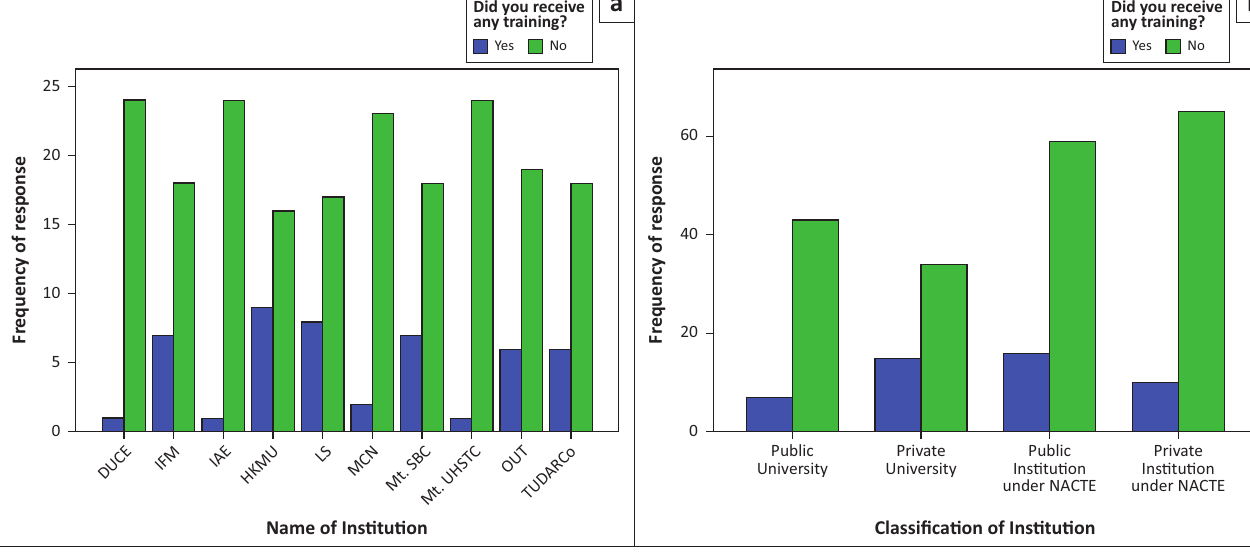
FIGURE 4: Level of training on fire preparedness in higher learning institutions. (a) Responses per institution and (b) responses per institution